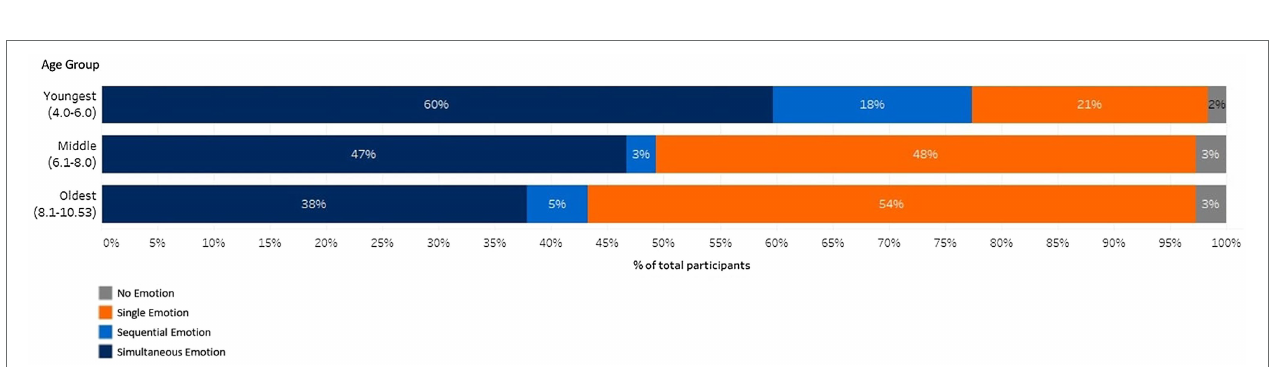
FIGURE 3 | Visualisations of the cluster analyses. The six cluster shapes found are along the y-axis. Within each cluster shape, the emotion intensity (0-155mm) is denoted. The x-axis shows each of the cluster shapes by positive or negative emotion and then by age group (representation created using the software